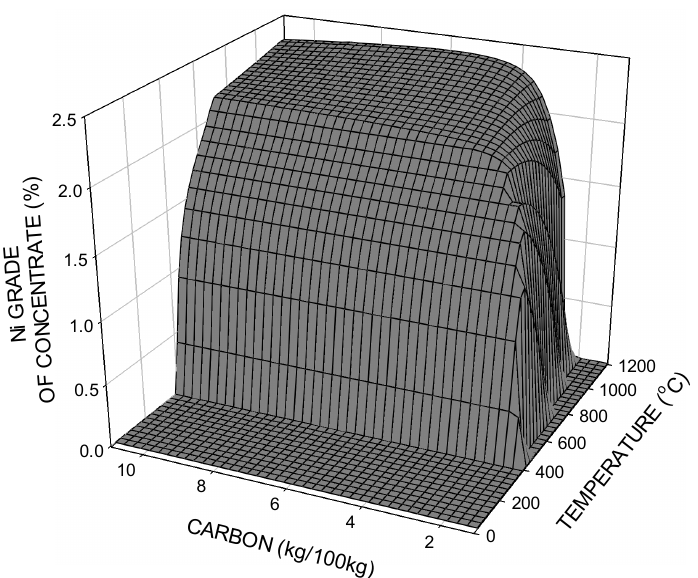
Figure 5. Effects of temperature and carbon additions on the grade of the magnetic concentrate (Fe + Ni + Co + Fe 3 O 4 ) for the limonitic ore.